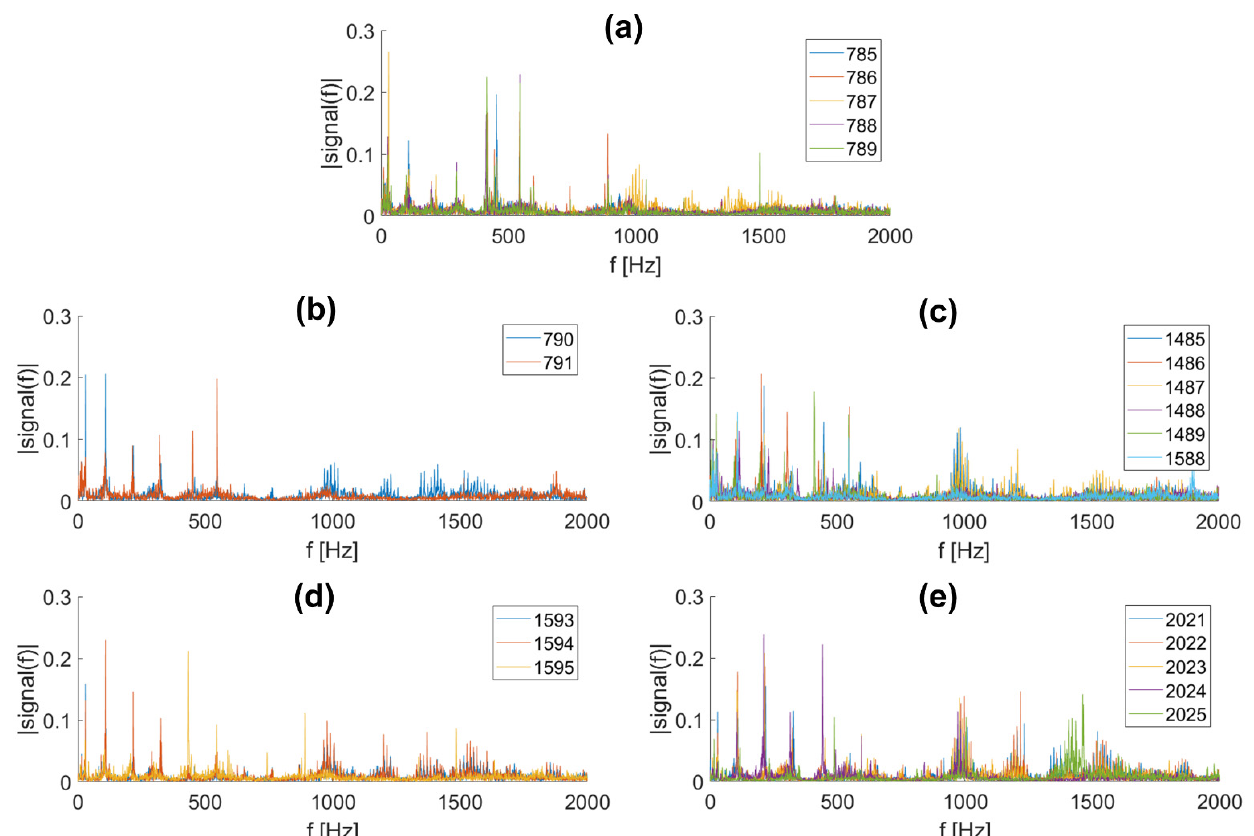
Figure 3. Fast Fourier Transforms (FFTs) of the segments of each set included in signal #2. ( a ): training set; ( b ): validation set #1; ( c ): validation set #2; ( d ): test set #1; ( e ): test set #2.